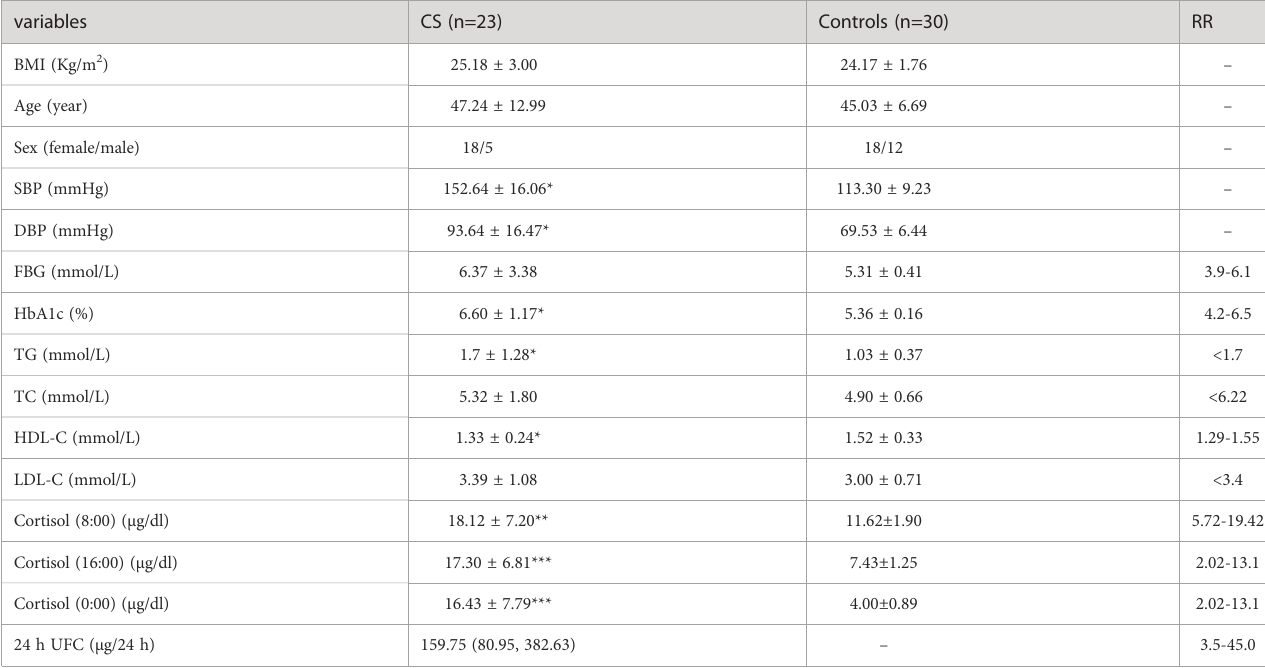
TABLE 1 Clinical characteristics of CS patients and